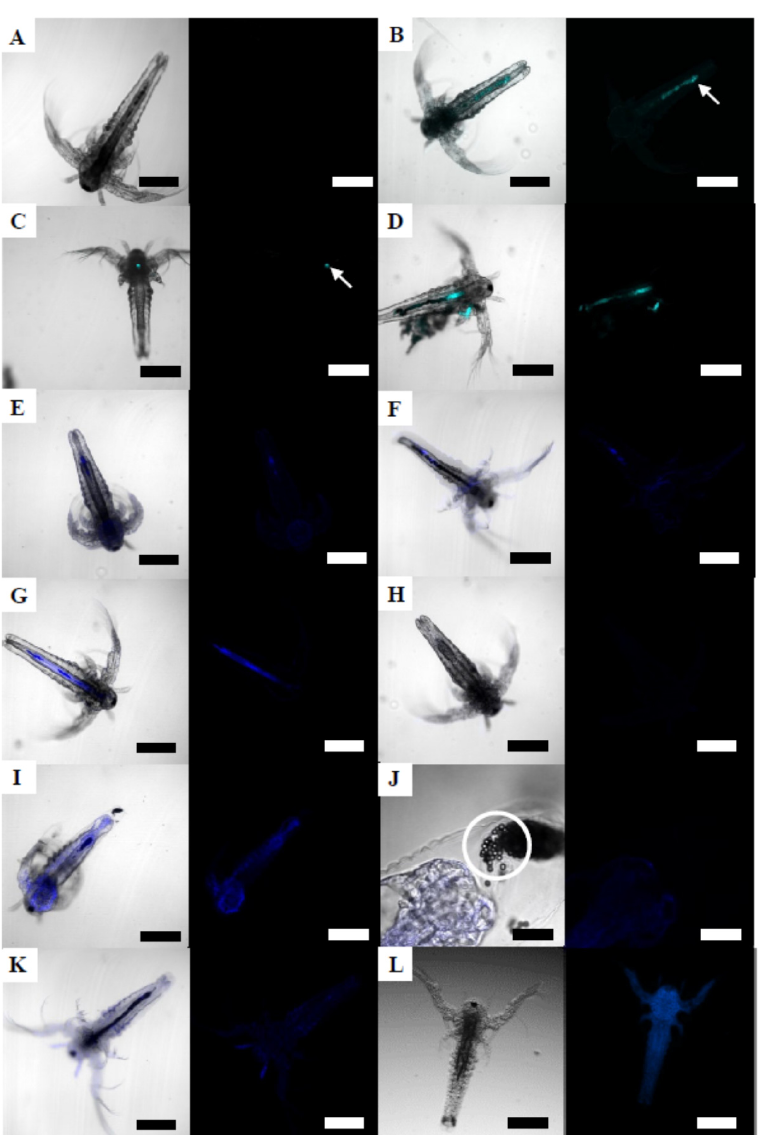
Figure 3. Confocal micrographs of brine shrimp larvae exposed to 50 nm NPs and to MPs with sorbed B(a)P ( A – K ) and Cytation 5 micrographs of larvae exposed to B(a)P alone ( L ). A) unexposed control larva at 72 hph; ( B ) 24 hph larva exposed to 6.87 mg/L of fluorescent NPs for 24 h, showing fluorescence along the digestive tract and in the feces (white arrow); ( C ) 24 hph larva exposed to 6.87 mg/L of fluorescent NPs for 48 h, showing fluorescence in the labrum (white arrow); ( D ) 48 hph larva exposed to 6.87 mg/L of NPs for 24 h showing fluorescence inside the digestive tract; ( E ) 24 hph larva exposed for 24 h to 6.87 mg/L of 500 nm NPs-B(a)P; ( F ) 24 hph larva exposed for 48 h to 0.00069 mg/L of 0500 nm NPs-B(a)P; ( G ) 48 hph larva exposed for 24 h to 6.87 mg/L of 500 nm NPs-B(a)P; ( H ) 24 hph larva exposed for 24 h to 50.1 mg/L of 4.5 µm MPs-B(a)P; ( I ) 24 hph larva exposed for 48 h to 50.1 mg/L of 4.5 µm MPs-B(a)P; ( J ) 4.5 µm MPs-B(a)P (white circle) excreted from the digestive tract of a 24 hph larva exposed for 48 h observed at higher magnification; ( K ) 48 hph larvae exposed for 48 h to 5.01 mg/L of 4.5 µm MPs-B(a)P; ( L ) 48 hph larvae exposed for 48 h to 0.1 mg/L of B(a)P. Scale bars: 200 µm ( A – I , K , L ) and 50 µm ( J ).